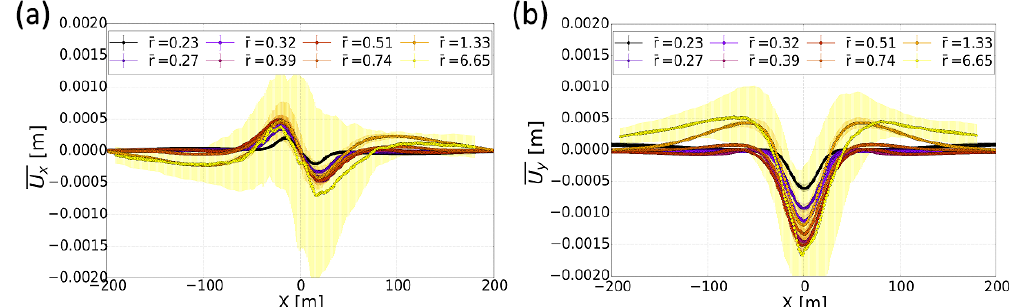
Figure B3. Results of convergence tests of for influence of particle size: horizontal (a) and vertical displacement (b) profiles for method M1 with in a 400 × 400m sized box. We observe a convergence of the displacement curves for mean radii around 0.32m, but for decreasing particle sizes, we observe further diminishing of the